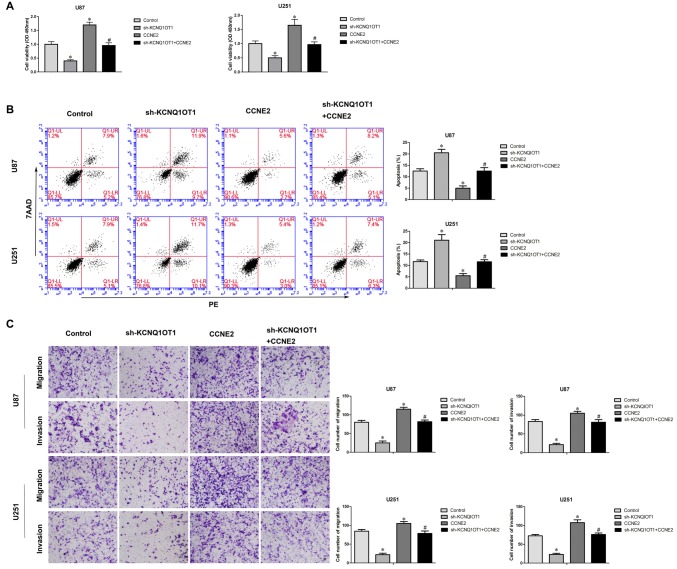
Sh-KCNQ1OT1 phenotype was reversed by over expression of CCNE2. (A) CCK-8 assay was used to determine the proliferation effect of sh-KCNQ1OT1 + CCNE2 on human glioma cells. *P < 0.05 vs. Control group; #P < 0.05 vs. sh-KCNQ1OT1 group. (B) Flow cytometry analysis of human glioma cells with the expression of CCNE2 changed. *P < 0.05 vs. Control group; #P < 0.05 vs. sh-KCNQ1OT1 group. (C) Quantification of migration and invasion cells with the expression of CCNE2 changed. Representative images and accompanying statistical plots were presented. *P < 0.05 vs. Control group; #P < 0.05 vs. sh-KCNQ1OT1 group. Scale bars represent 20 μm.